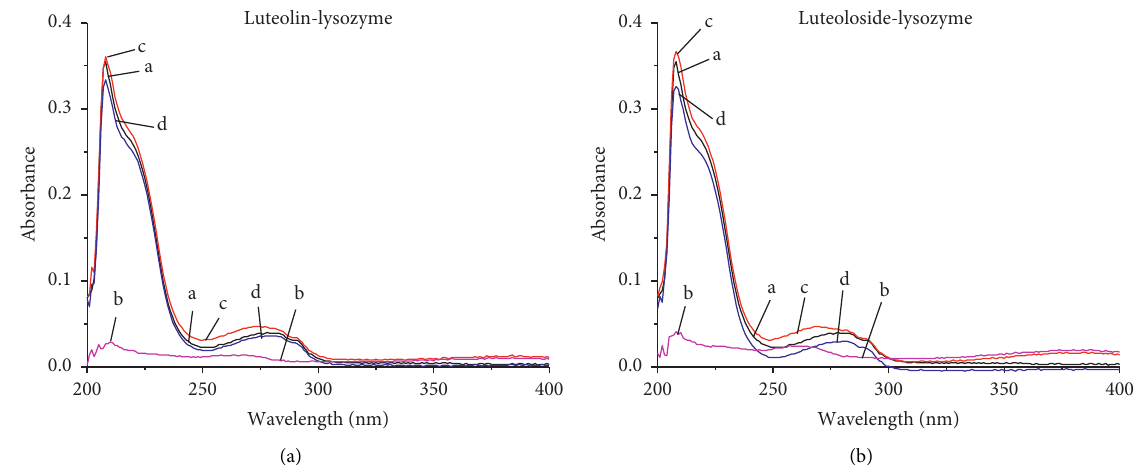
Figure 3: The absorption spectra of LYSO, luteolin (or luteoloside), and luteolin (or luteoloside)-LYSO system. (a) LYSO, (b) luteolin (or luteoloside), (c) luteolin (or luteoloside)-LYSO, and (d) luteolin (or luteoloside)-LYSO-luteolin (or luteoloside); C (LYSO) � C (luteolin) � C (luteoloside) � 1.0 μ